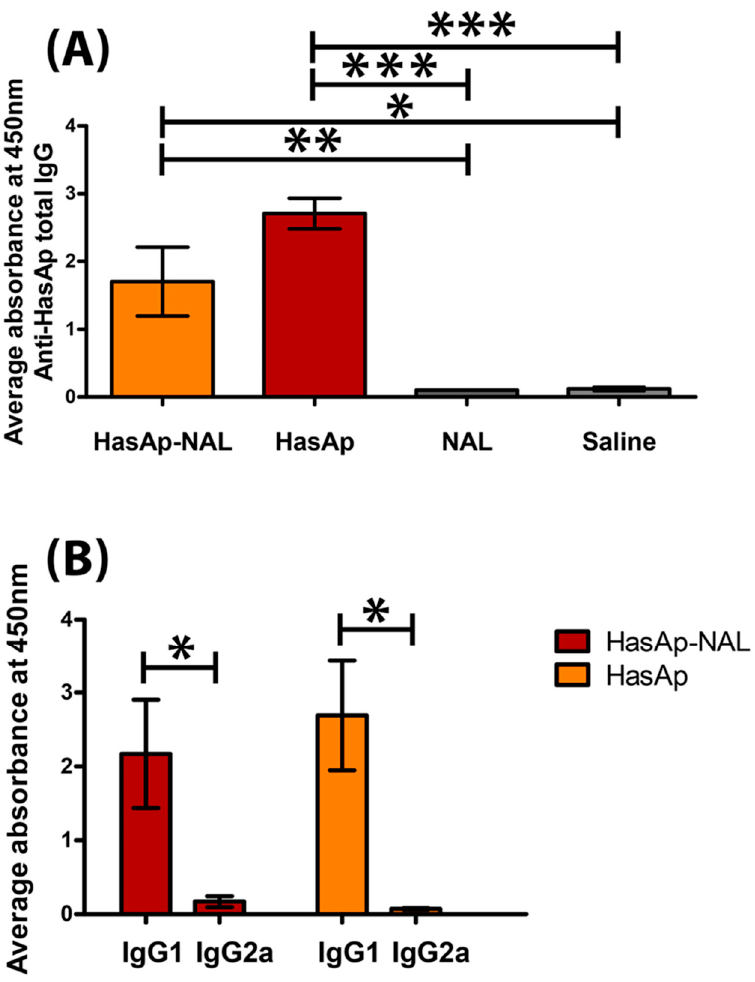
Figure 5. Indirect enzyme-linked immunosorbent assay (ELISA). Results represent absorbance readings at 450 nm averaged for all mice sera in each group. Wells were coated with purified HasAp antigen and primary antibodies were sera collected from mice 2 weeks after the fourth immunization before challenge, diluted 1/1000. Secondary antibodies were peroxidase-labeled anti-mouse IgG (total) ( A ) or anti-mouse IgG1 or IgG2a ( B ). Error bars represent mean ± SE (standard error of the mean). *: p -value ≤ 0.05, **: p -value ≤ 0.01, ***: p -value ≤ 0.001. One-way analysis of variance (ANOVA) was used, followed by Tukey’s test for post hoc analysis.